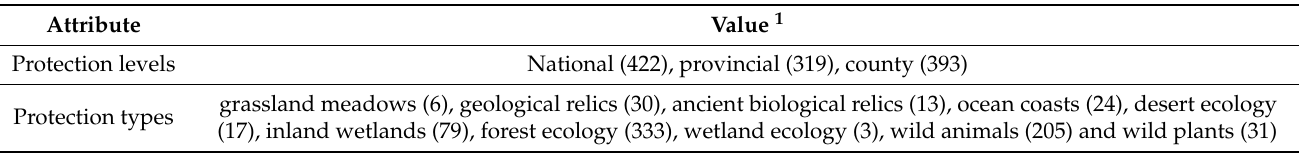
Table 1. General information on Nature Reserves in